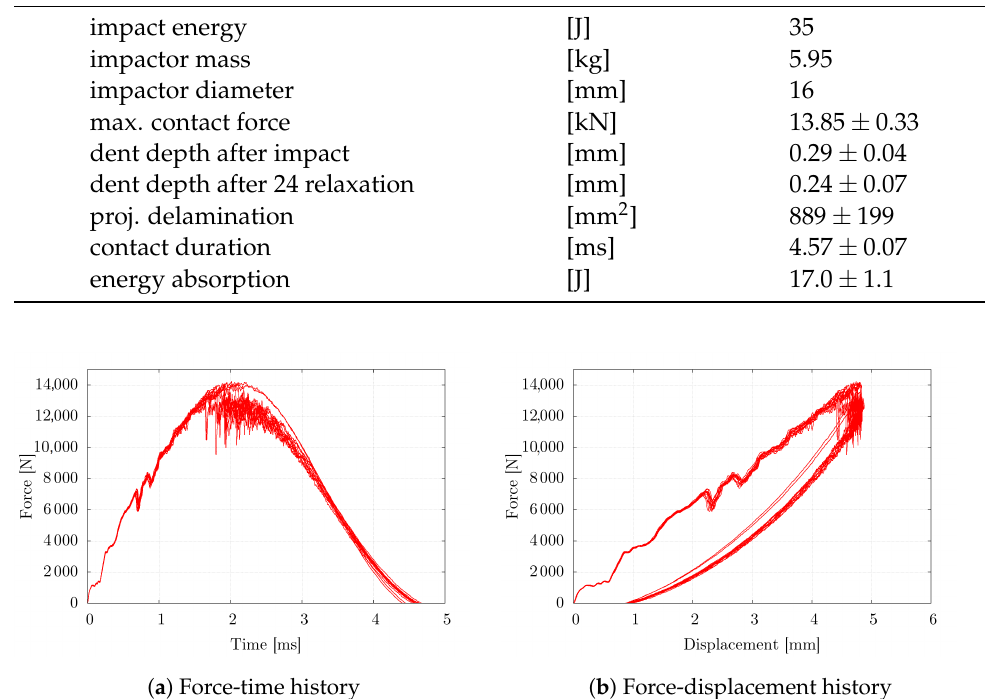
Figure 2. Set of force-time and force-displacement history curves of the 35J CAI impacts